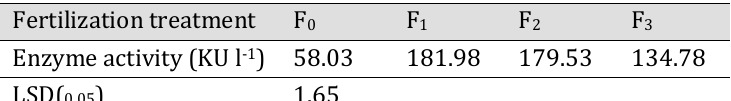
Table 5. Effect of fertilization with potassium and micronutrients in catalase enzyme activity CAT (KU l -1 ) in wheat